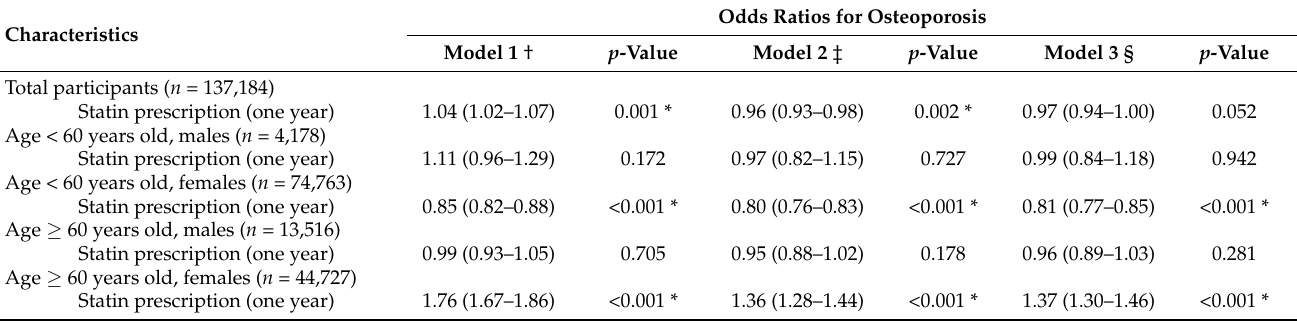
Table 2. Odds ratios (95% confidence interval) of the date of statin use (one year) for osteoporosis with subgroup analyses according to age, sex, income, and region of